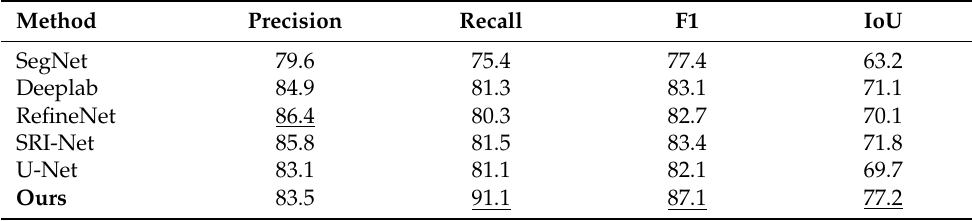
Table 2. Quantitative comparison (%) with several SOTA methods on the Inria Aerial Image Labeling Dataset (the highest values are underlined). The first three methods and SRI-Net were implemented by [4], who cropped the Inria aerial images to tiles of 256 × 256